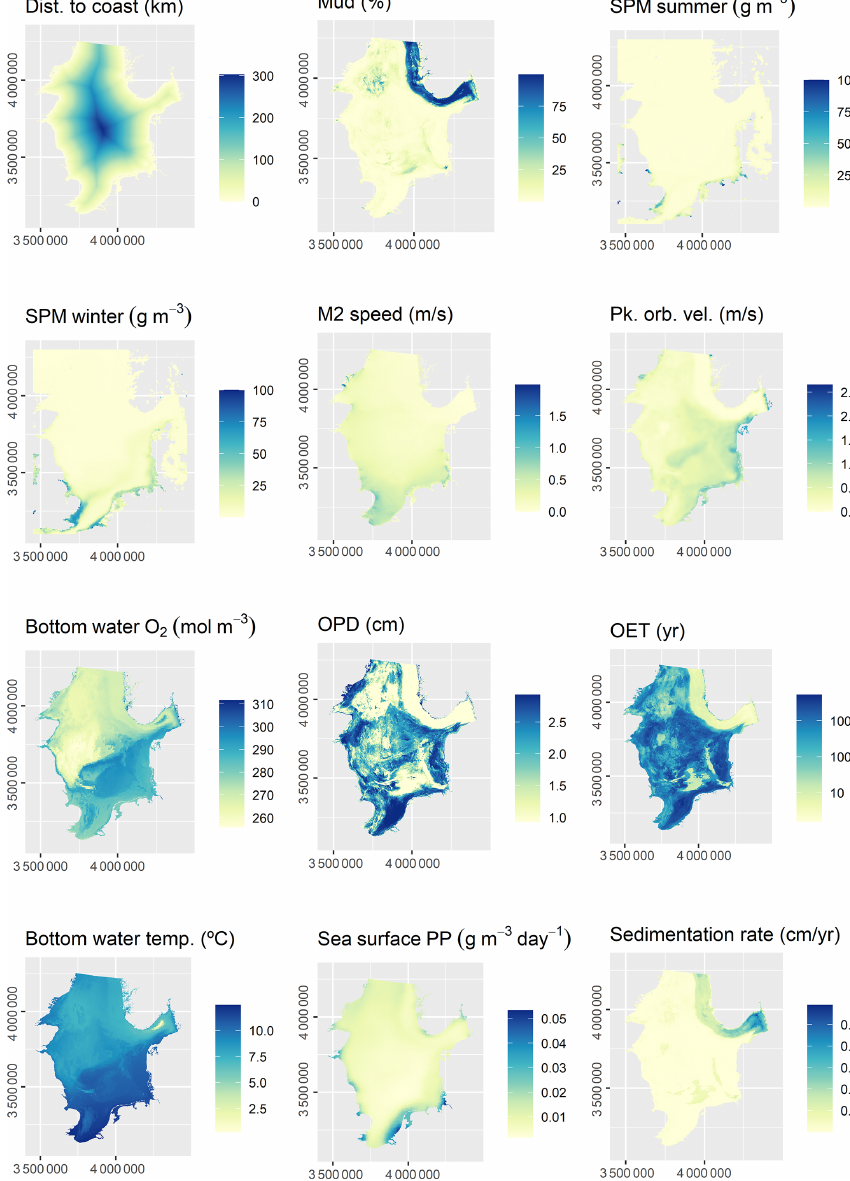
Figure A3. Selected predictor variables of the OC density model. Bathymetry was also selected but is not shown